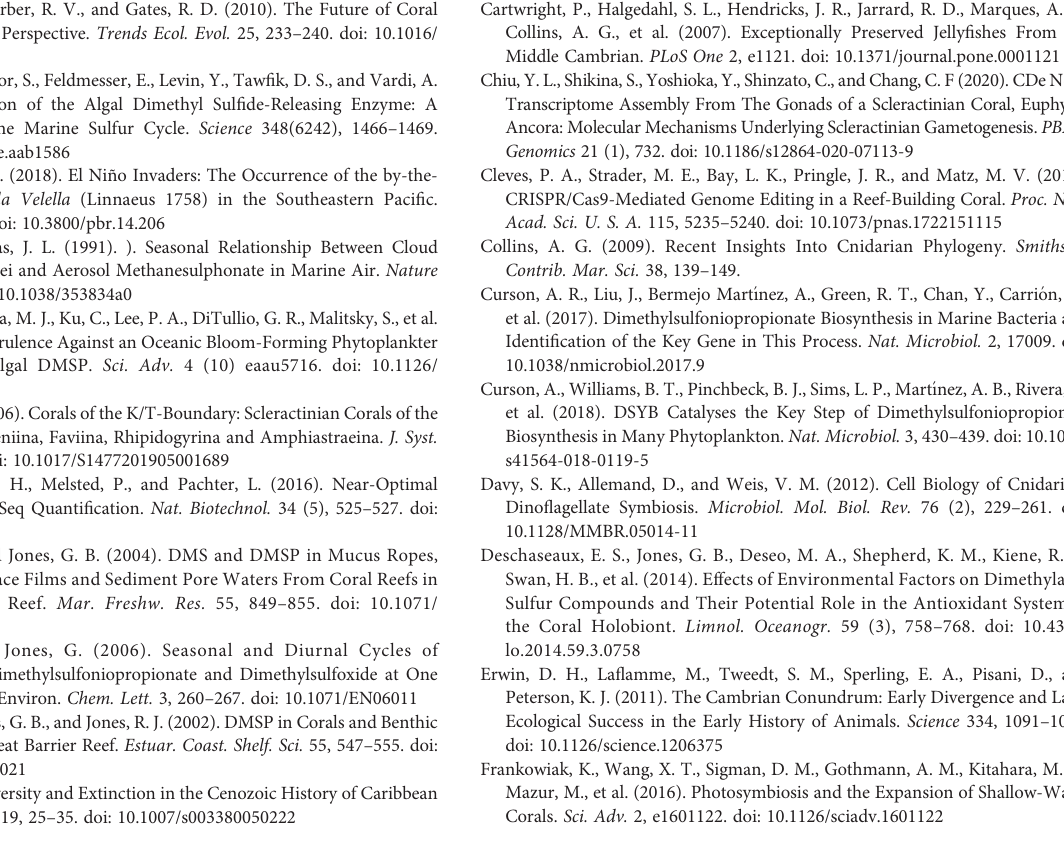
Supplementary Figure 2 | Maximum likelihood analysis of DL-L genes identi fi ed from transcriptomic databases of eukaryotes. A total of 65 DL-L genes from